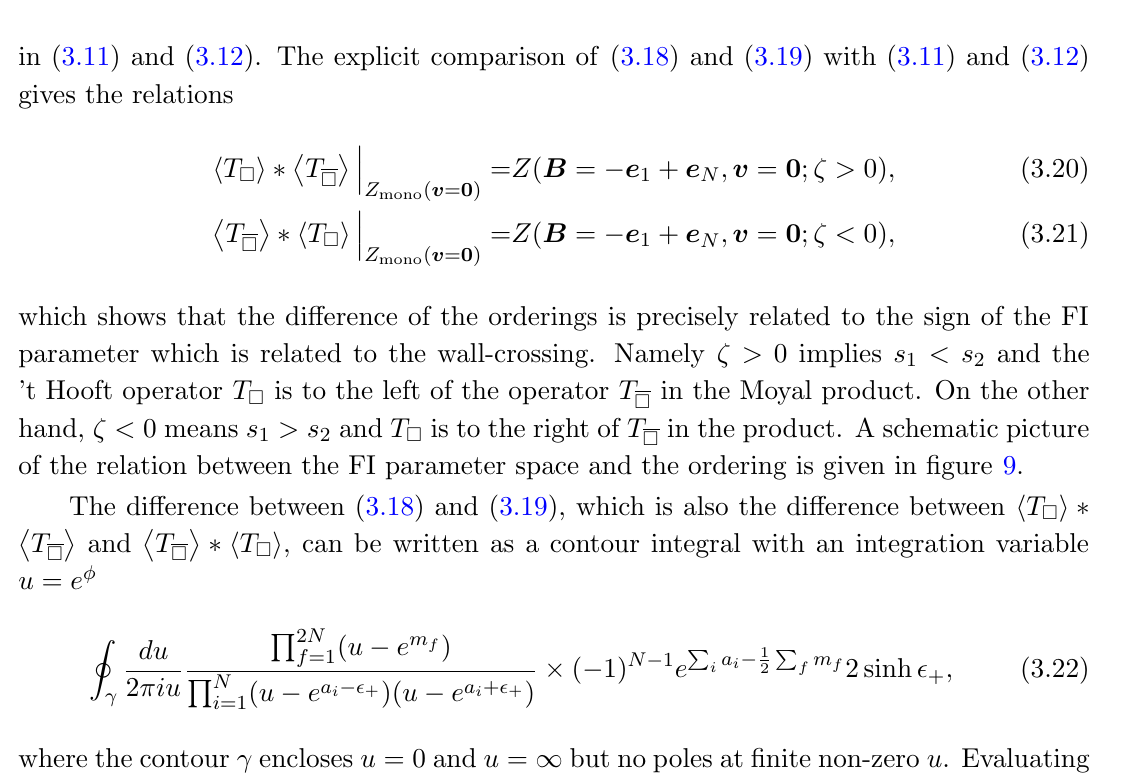
Figure 9 . The relation between the order of the Moyal product and the sign of the FI parameter in the case of the v = 0